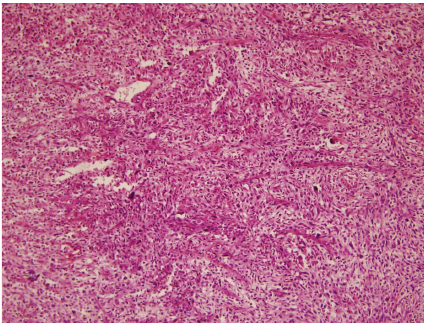
Figure 4: Microscopic image of the biopsy, stained with H&E; spindle cells composing storiform pattern (H&E ×